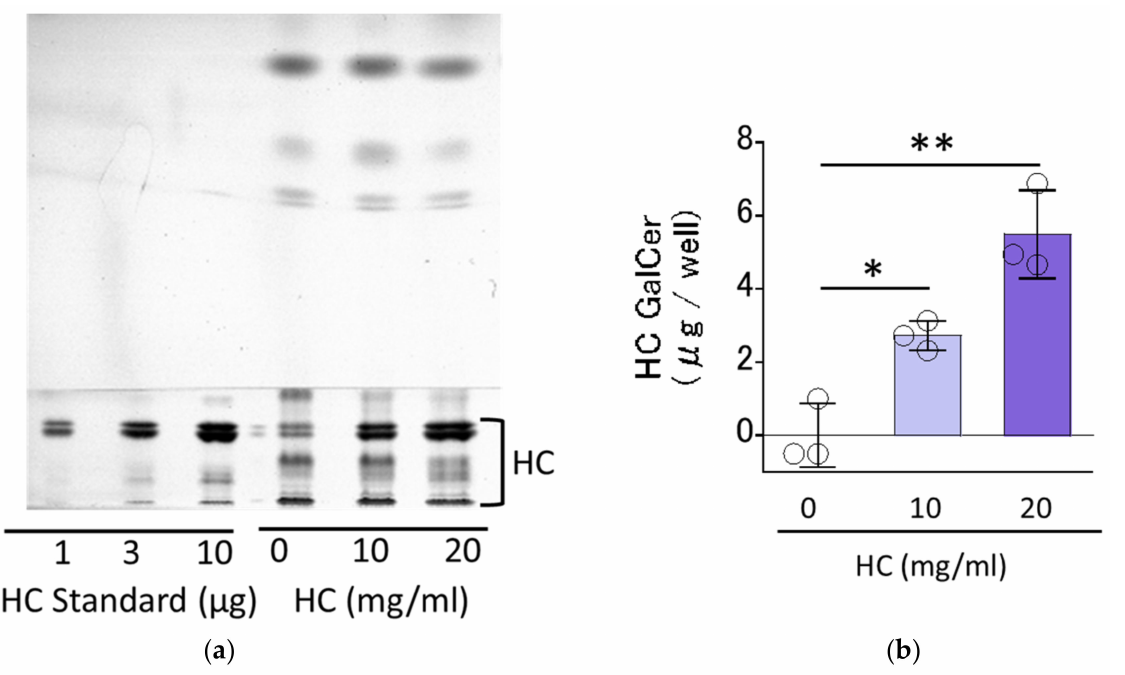
Figure 1. Residual levels of HC on RHEEs. ( a ) HPTLC chromatogram. ( b ) Levels of HC. A total of 4% HC glycerin aqueous solution (at 0, 10 and 20 mg/mL) was applied for 3 h on the surface of RHEEs, which were then washed with PBS. The RHEEs were then extracted with chloroform, methanol and PBS as described in the Section 4 Materials and Methods (Section 4.4 Evaluation of the residual level of HC applied on RHEEs) to obtain total lipids with applied and remaining HC. The total lipids were subjected to HPTLC analysis to measure the residual levels of HC in RHEEs. HC contents are expressed as µ g/well. Bars represent mean ± standard deviation (SD), n = 3, Dunnett’s multiple comparison test. *: p < 0.05, **: p <